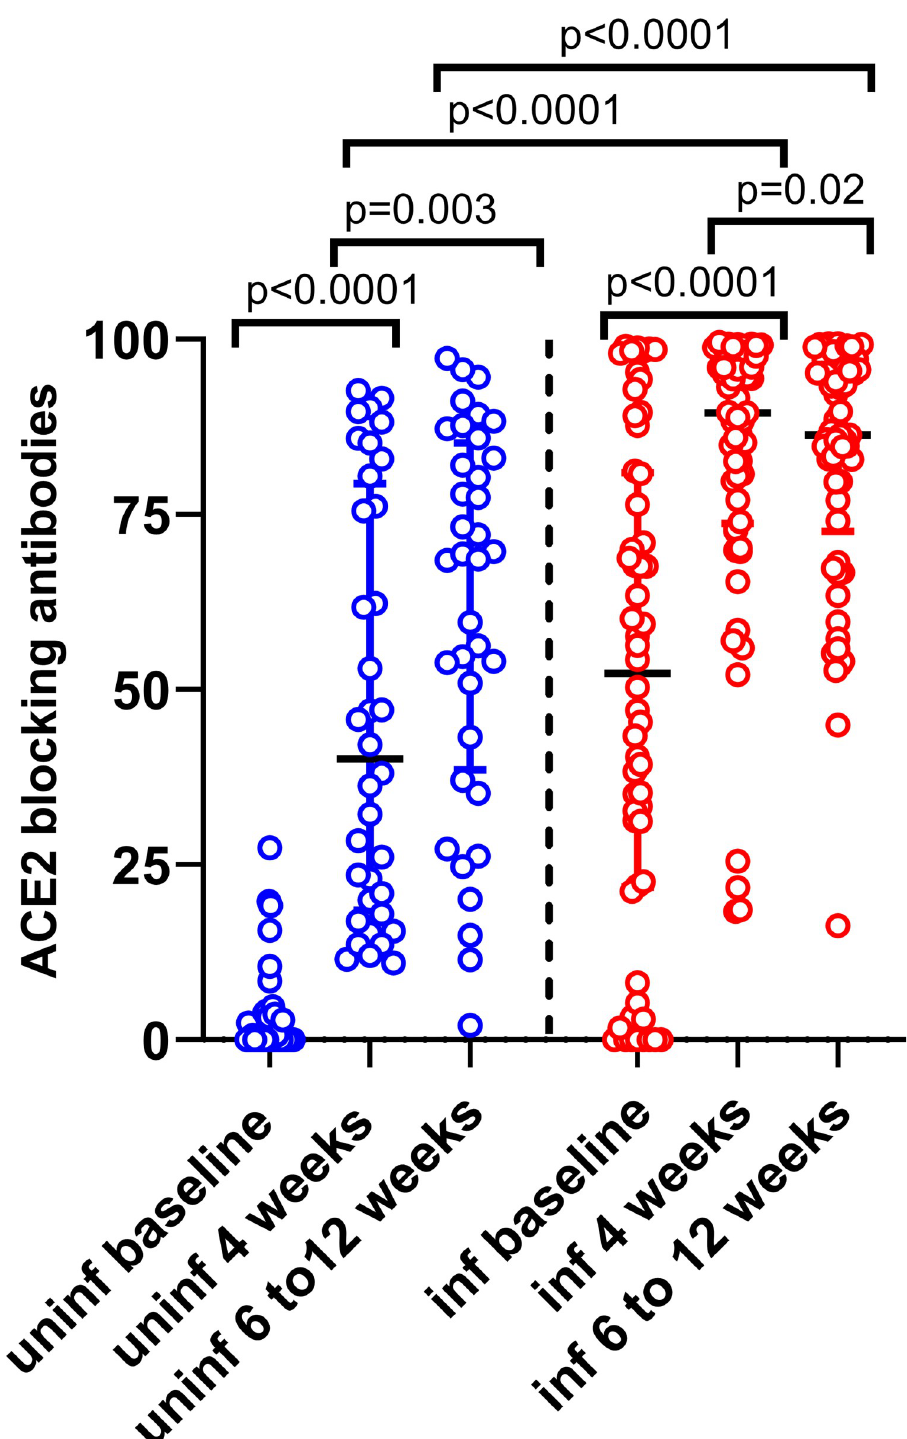
Fig 2. ACE2 blocking antibodies following first and second dose of the sinopharm/ BBIBP-CorV vaccine. The ACE2 receptor blocking antibodies were measured by the surrogate virus neutralizing test in baseline uninfected (n = 36) and infected (n = 58) pregnant women. Wilcoxon matched-pairs signed rank test was used to compare the means of the antibody indexes, before and after the vaccine, while the Mann-Whitney U test was used to calculate the differences in antibody responses at each time point in baseline infected and uninfected women. All tests were two- tailed. The lines indicate the median and the inter quartile range.